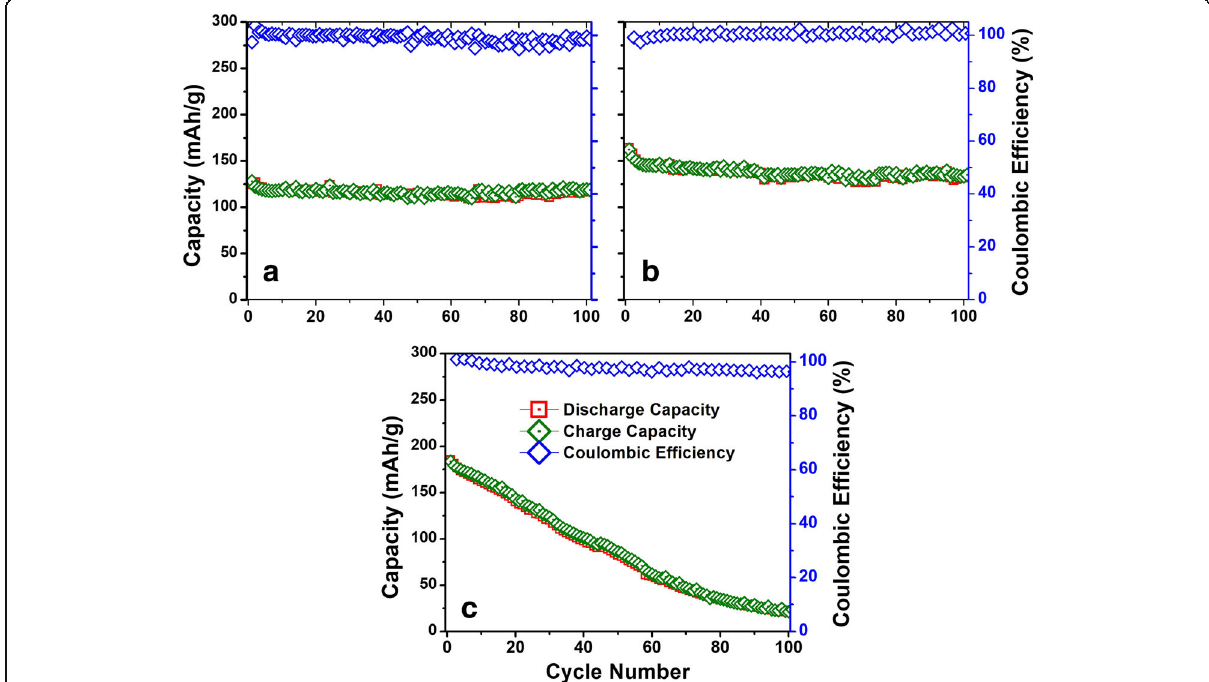
Fig. 8 Na-ion battery cycling performance of ( a ) a-VOx-6 Pa, ( b ) a-VOx-13 Pa and ( c ) a-VOx-30 Pa films at 0.1 C